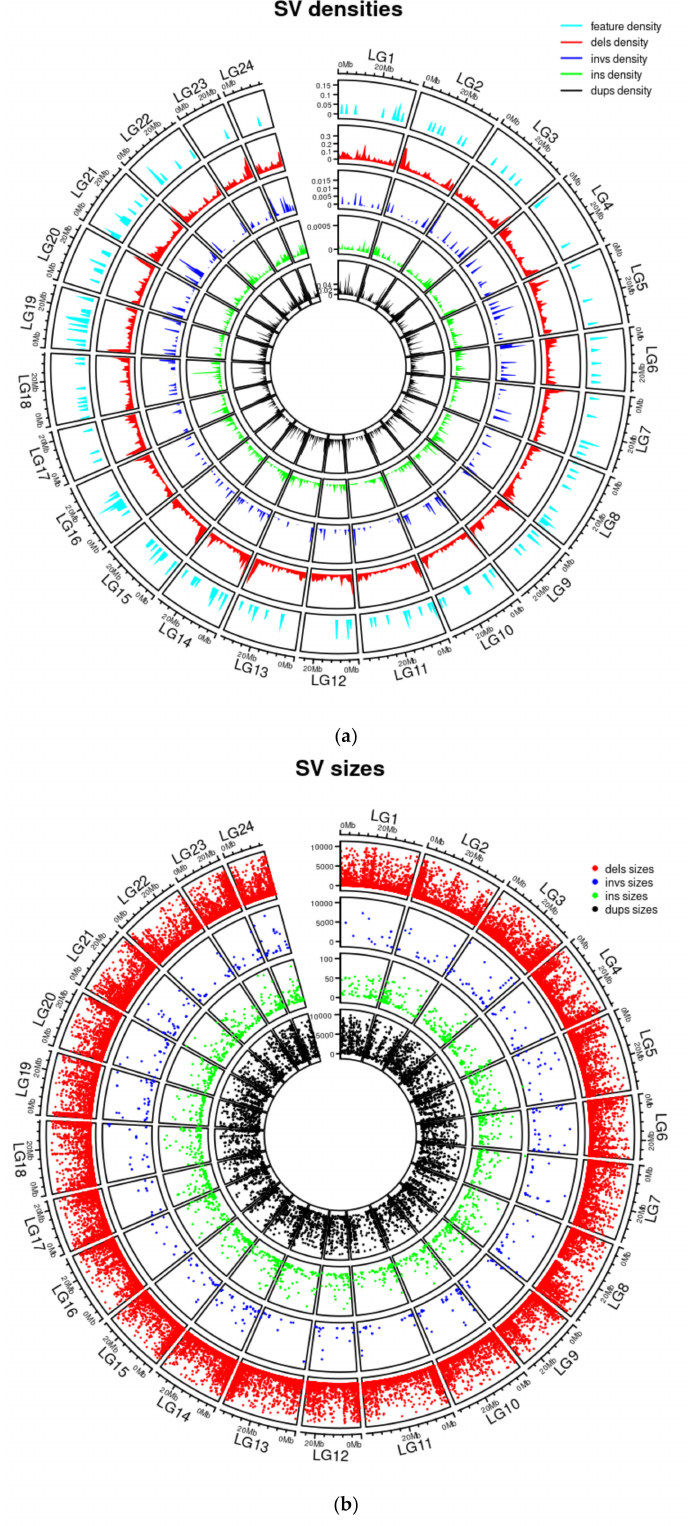
Figure 3. Circos plots of density (proportion of 100 kb genomic windows covered by variant class, ( a ) and locations and sizes (in base pairs, ( b )) of structural variants called by Parliament2 within the 32 F2 samples and merged by SURVIVOR. In addition, the density plot shows the top 25 growth areas from the relief feature selection of SNPs and structural variants. In legends, dels = deletions, invs = inversions, ins = insertions, and dups =